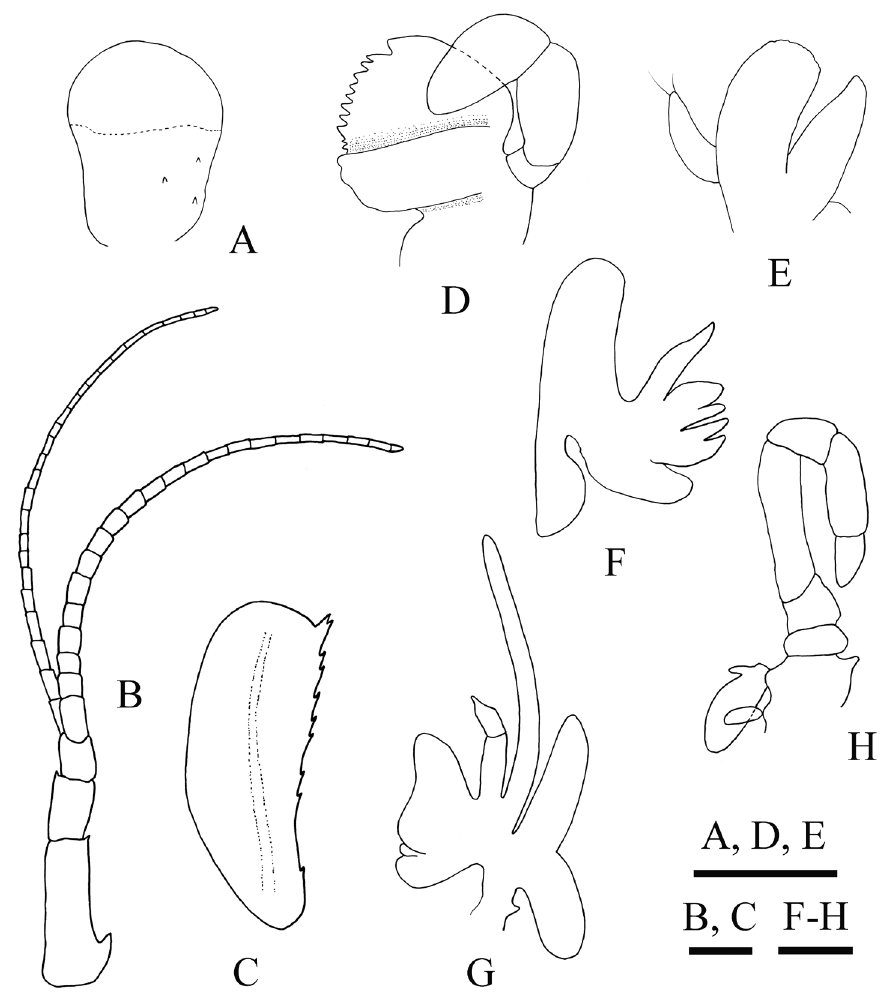
Figure 3. Spongicoloides weijiaensis sp. n. Holotype female: A right eye, outer view B right antennule, dorsal view C right antennal scale, dorsal view D right mandible, inner view E right maxillule, outer view F right maxilla, outer view G left first maxilliped, outer view H left second maxilliped, inner view. Setae omitted. Scale bars 1